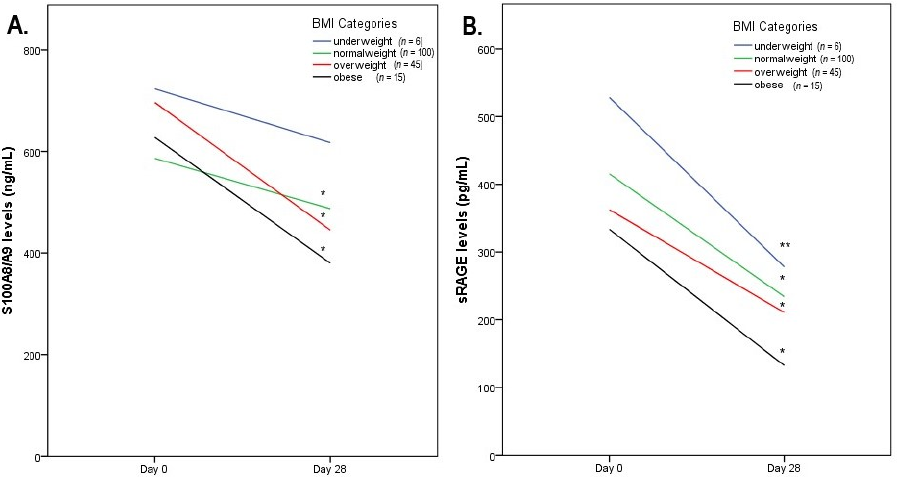
Figure 3. Line charts with biomarkers’ changes across BMI categories for S100A8/A9. ( A ) * p < 0.001 vs. baseline; sRAGE ( B ) * p < 0.001 vs. baseline, ** p < 0.005 vs. baseline. BMI Categories according to WHO Classification: <18.5 underweight, 18.5–25 normal weight, 25–30 overweight, >30 obese.